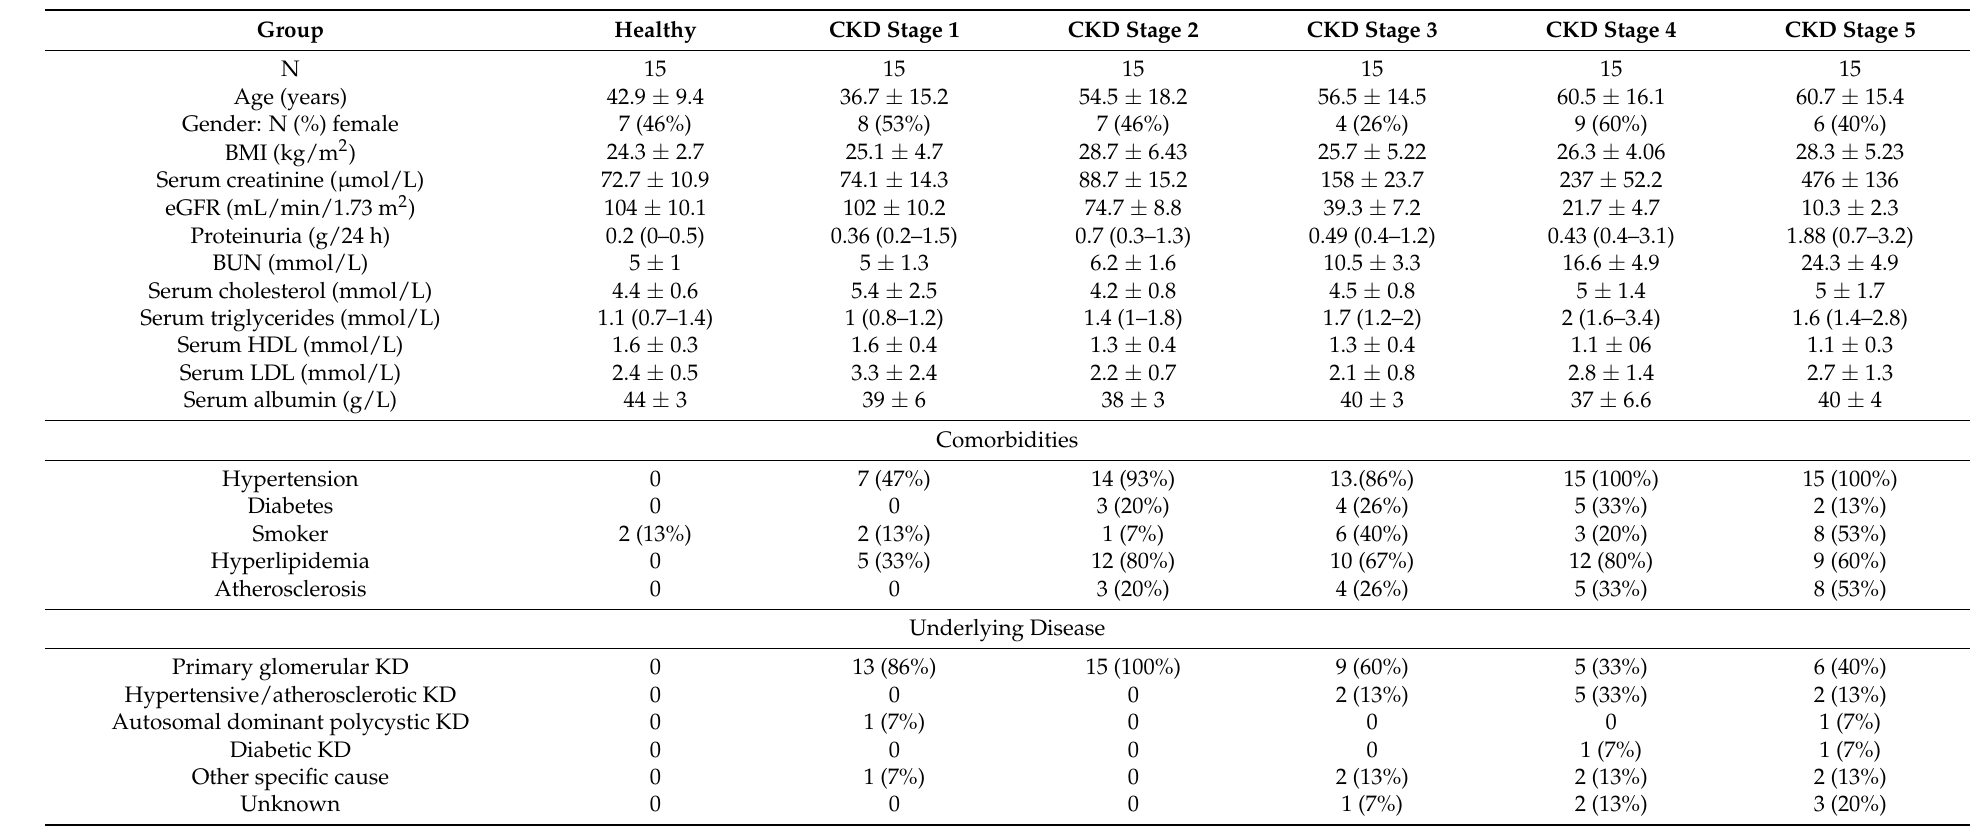
Table 1. Participants’ characteristics at the time of plasma sampling, categorized according to the stage of chronic kidney disease. Gender, comorbidities and underlying diseases are reported as number of participants (percentage). Age, body mass index and serum creatinine are reported as mean ± standard deviation. Proteinuria is reported as median (first and third quartile). Patients with hyperlipidemia were on statin therapy at the time of plasma